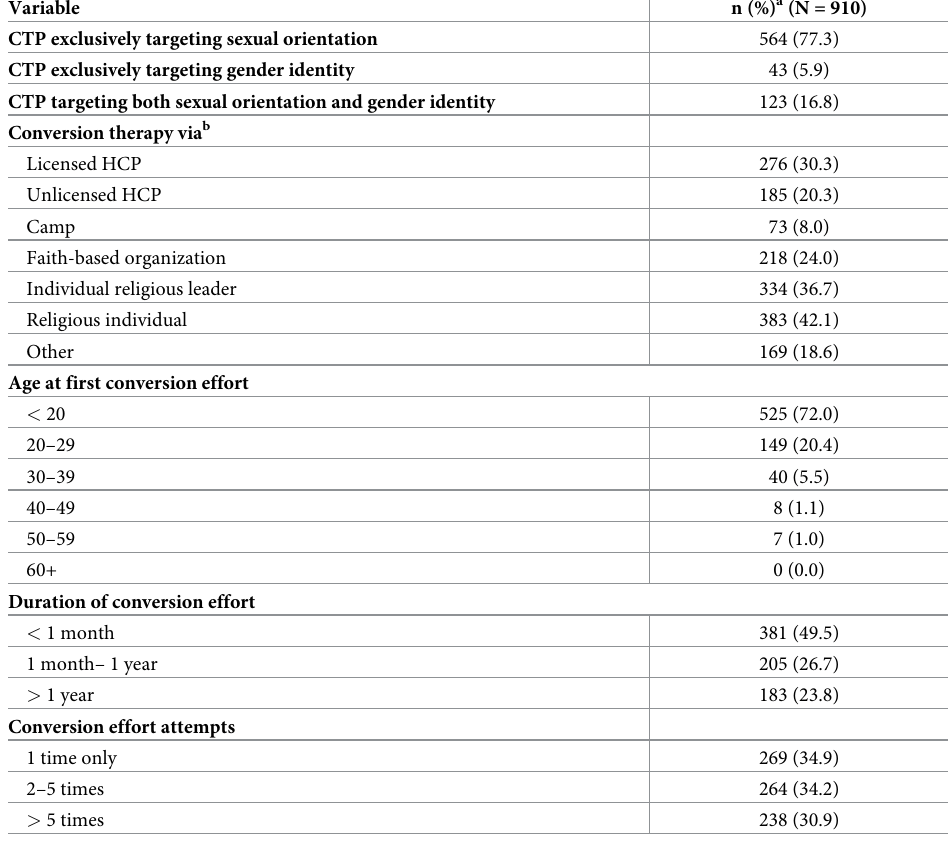
Table 4. Characteristics of conversion therapy among sexual and gender minority Canadian men,